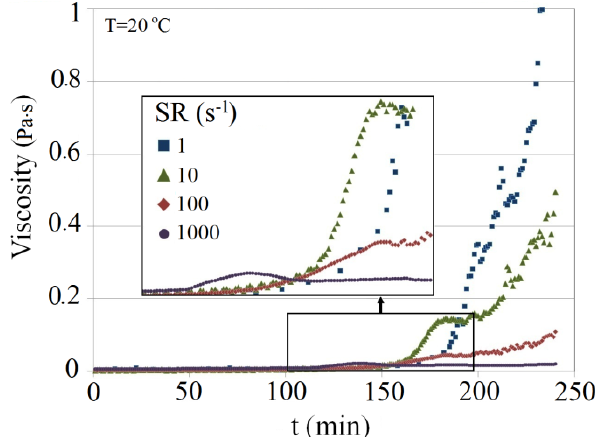
Figure 13. Viscosity profiles for 4.5 wt% Na-silicate with a pH of 10.30, measured at shear rates of 1, 10, 100 and 1000 s − 1